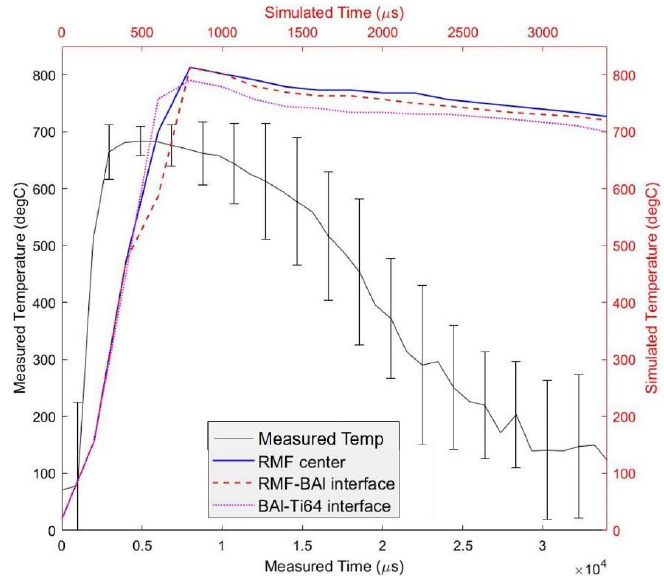
Figure 9. Temperature as a function of time simulated by LAMPS © (red, blue, and magenta lines) and measured using the highspeed camera (black solid line).